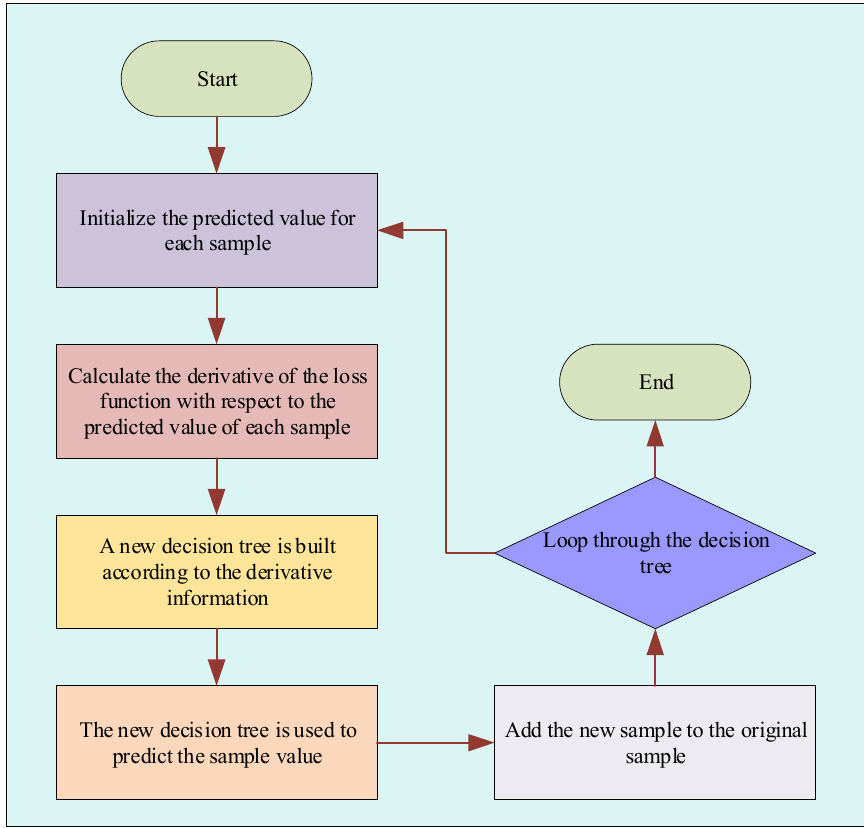
Figure 3. Overall flow chart of XGBoost.